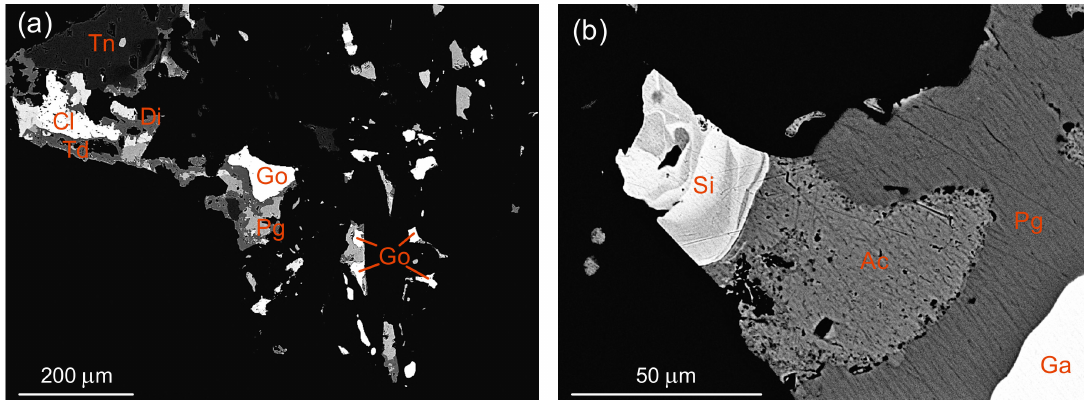
Figure 5. ( a ) Ag-rich gold (Go) in association with pyragyrite (Pg), clausthalite (Cl), diaphorite (Di), Ag-rich tetrahedrite (Td), and Ag-rich tennantite (Tn); ( b ) zoned silver (Si) with variable Au contents (18–57 wt %) in association with Se-rich acanthite (Ac), pyrargyrite (Pg), and galena (Ga); both back-scattered electron (BSE)